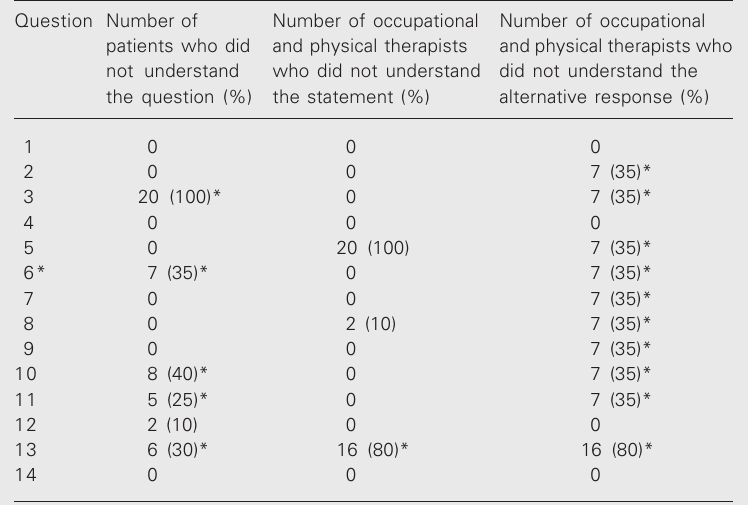
*Questions that were modified as a result of the